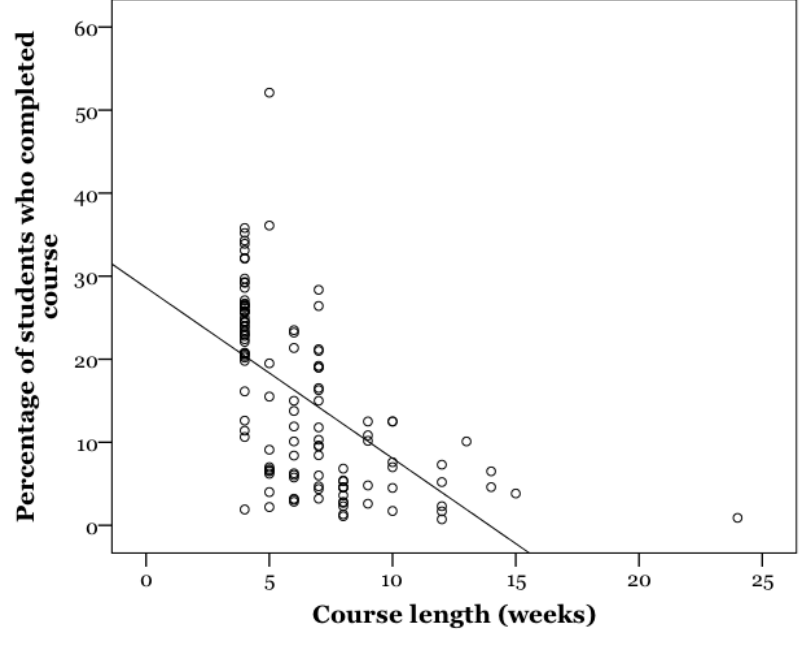
Figure 3 . Completion rate plotted against course length in